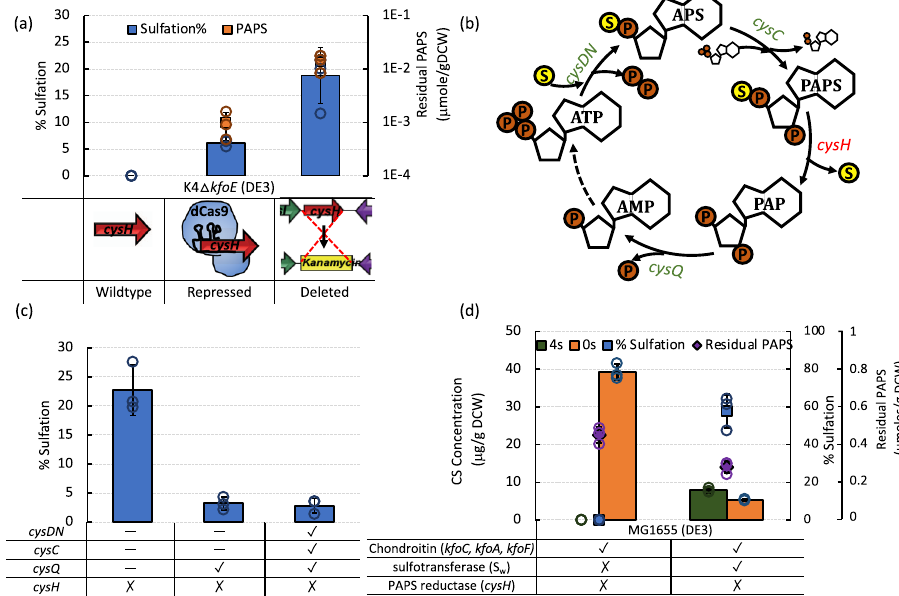
Fig. 2 Effect of PAPS accumulation on CS sulfation. a CS sulfation and residual PAPS in K4 Δ kfoE (DE3)pETM6-S w strains with wildtype, repressed and deleted cysH . b Biosynthetic route for PAPS synthesis. c Effect of overexpression of PAPS biosynthetic enzymes on CS sulfation in K4 Δ kfoE (DE3)pETM6-S w . d CS titer, residual PAPS and sulfation in MG1655 Δ cysH (DE3) expressing chondroitin synthesis and sulfotransferase enzymes. (Xs = CS disaccharide sulfated in the X position of N -acetylgalactosamine). Error bars represent standard deviation from three biological replicates. Source data underlying Figs. 2a, c, and d are provided as a Source Data fi